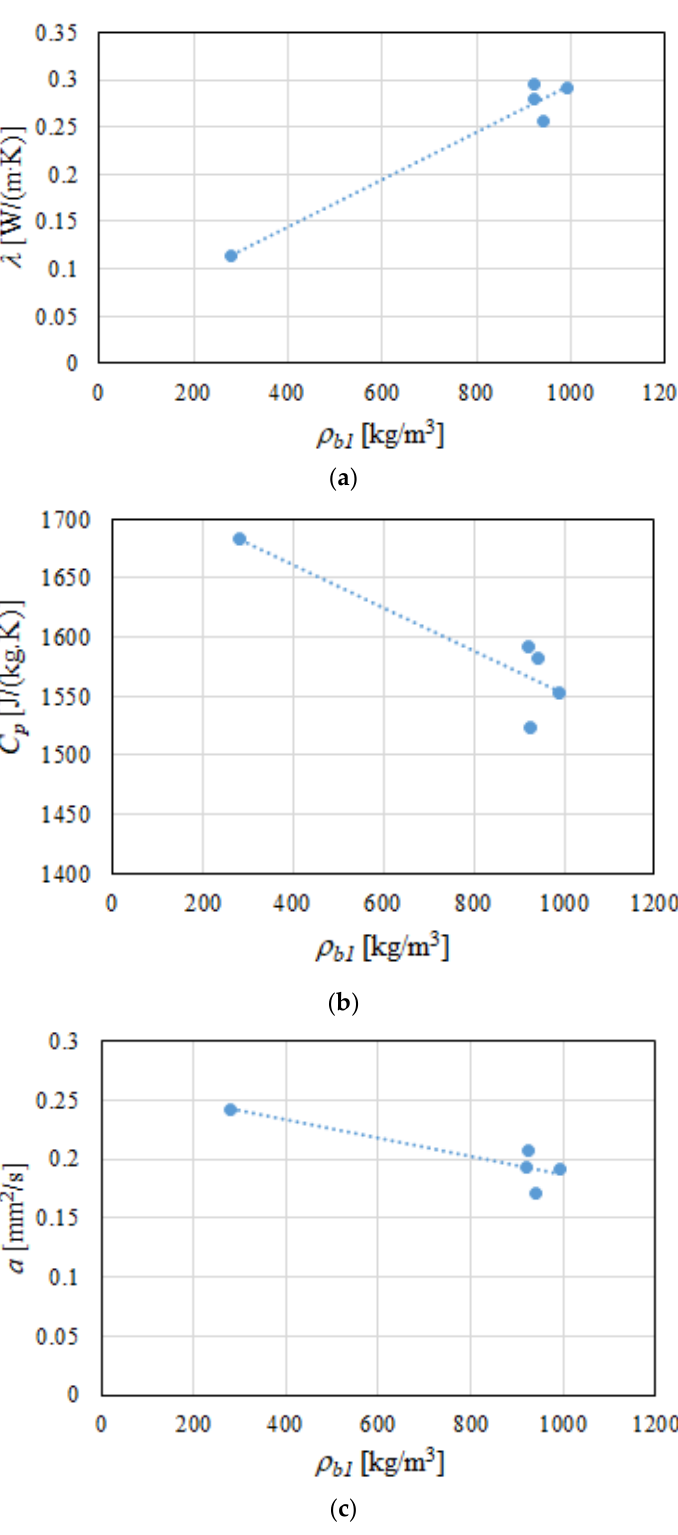
Figure 5. Graphs of the dependence of the ( a ) thermal conductivity, ( b ) specific heat, and ( c ) thermal diffusivity as a function of density for the modified gypsum samples and geopolymer. For the tested samples, dependencies Equations (7)–(9) were proposed; for the bulk density of the used building materials, they ranged from 281 kg/m 3 to 991 kg/m 3 .